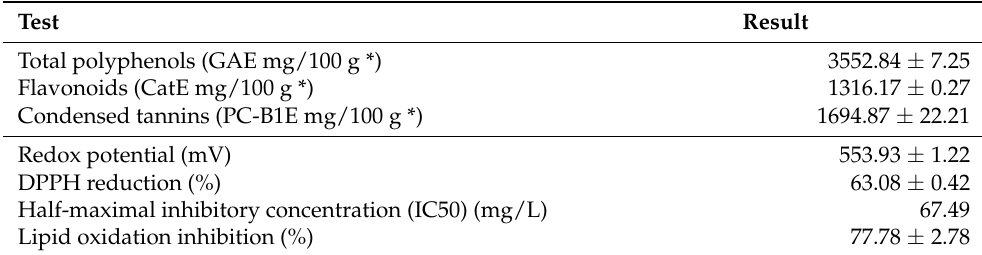
Table 4. Quantitative characterization of the phenolic content and antioxidant activities of the purified polyphenolic fraction of H. patens